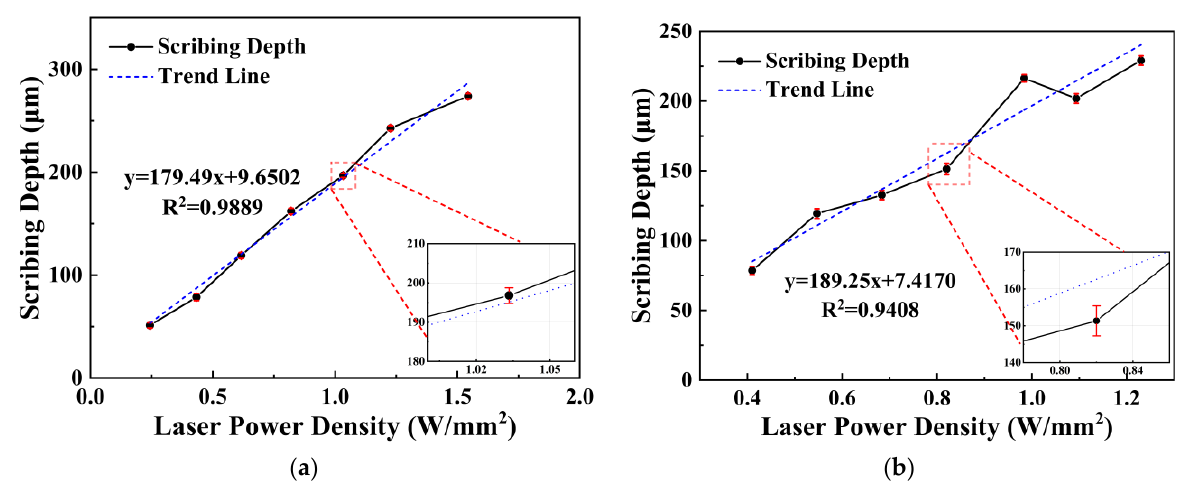
Figure 11. Relationship between laser power and speed with scribing depth. ( a ) Relationship be- tween scribing power and scribing depth; ( b ) Relationship between scribing speed and scribing depth.